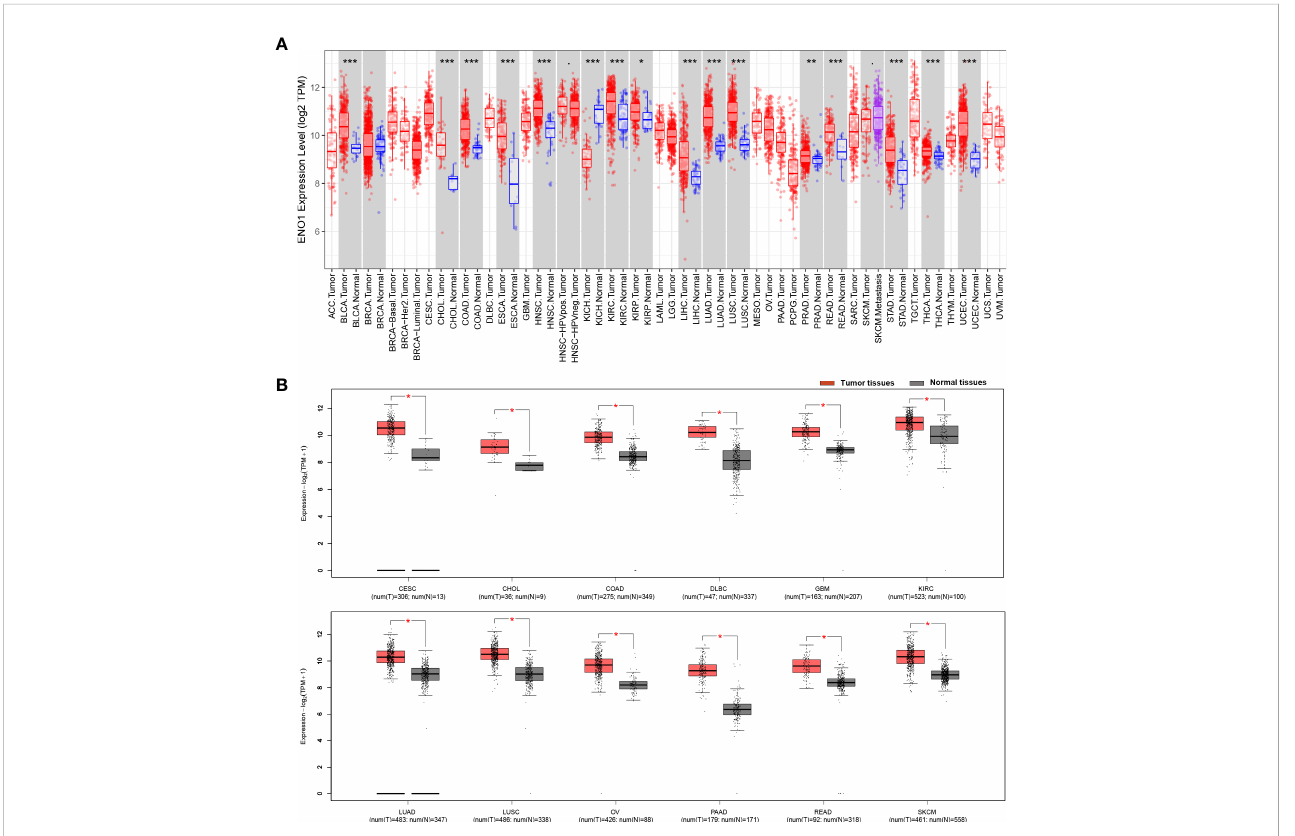
FIGURE 1 ENO1 expression is mostly upregulated different cancer types. ENO1 expression levels in different cancers and paired normal tissue were screened from the TCGA database using (A) TIMER (*P < 0.05, **P < 0.01, ***P < 0.001) and (B) GEPIA. T, tumor tissues; N, normal